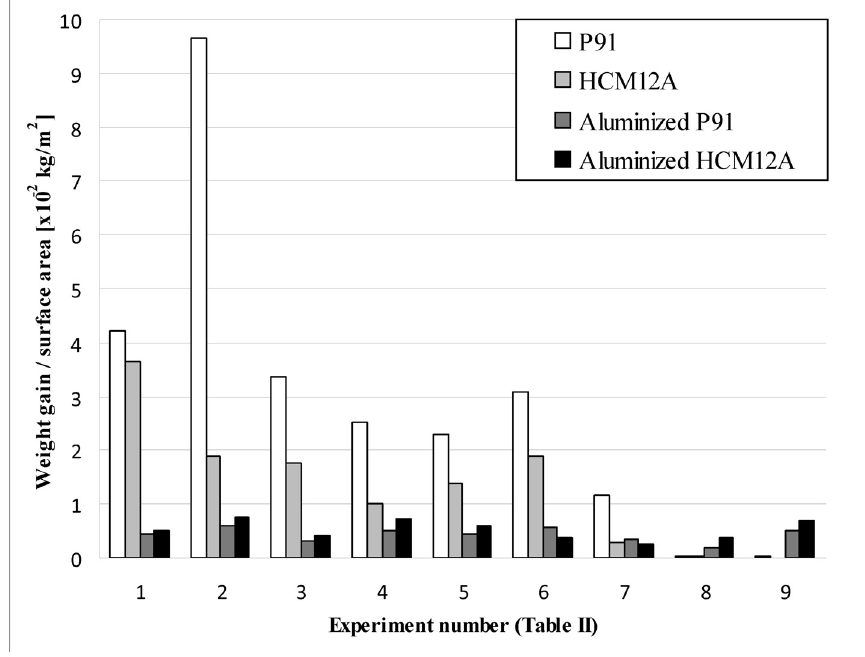
Figure 8. Relative weight gains for specimens exposed for 336 hours. Test atmospheres and temperatures are shown in